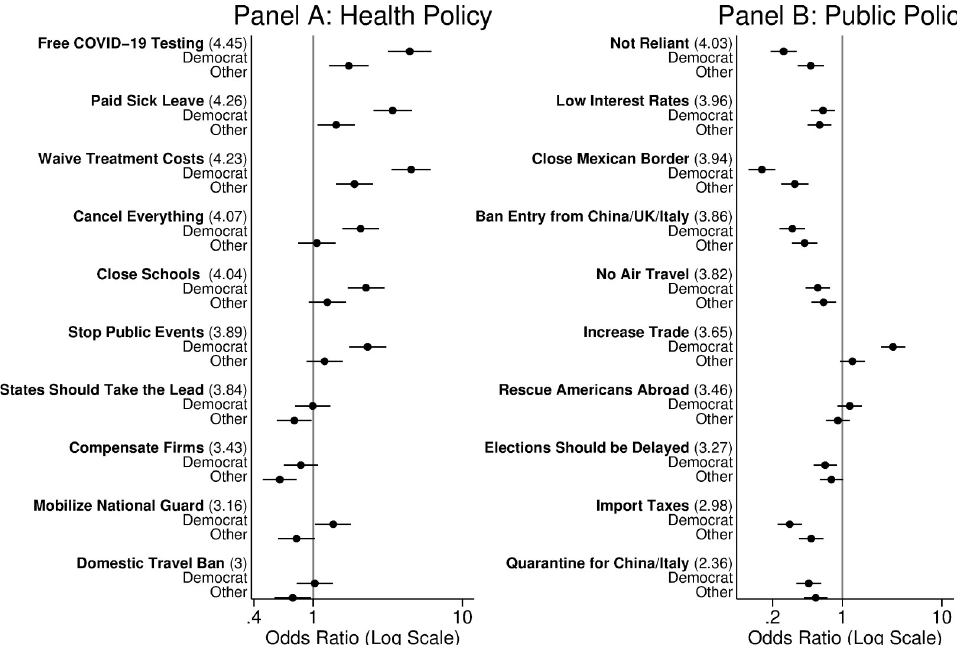
Fig 2. Partisanship and policy preferences. Odds ratios greater than 1 imply the respondent is more likely to support a policy. 95% confidence intervals are adjusted for twenty comparisons using a Bonferroni correction. For each dependent variable, the number in parentheses is the mean response on a five-point